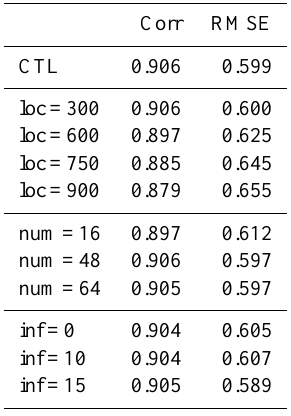
Table 2. The performance of the data assimilation for differ- ent parameters: the horizontal localization length (loc in km), the covariance inflation (inf in%), and the ensemble number (num). Five-day mean (averaged over 7–11 January 2005) tropospheric NO 2 columns from the assimilation and from DOMINO v2 are compared. Corr is the global spatial correlation coefficient and RMSE is the root-mean-square error in 10 15 molec . cm − 2 . The control (CTL) simulation was conducted with loc=450, inf=5, and